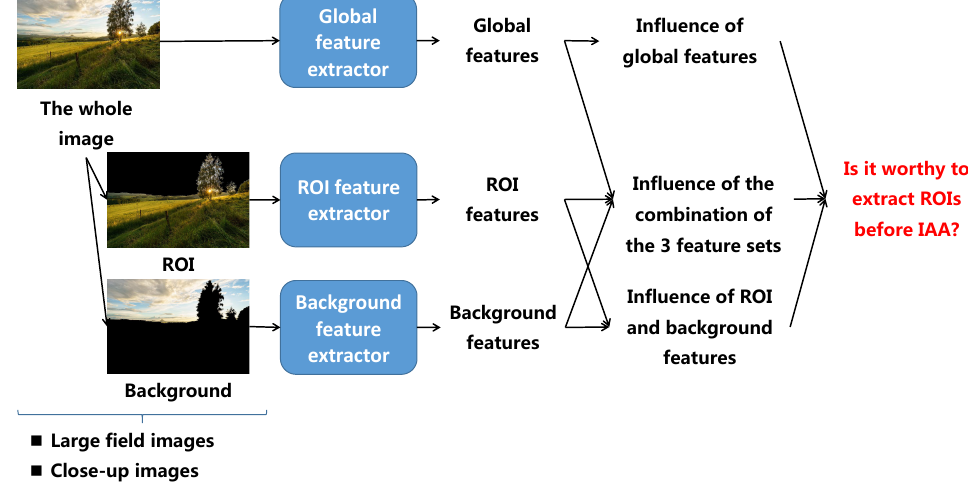
Figure 3. The process of image aesthetic study based on ROIE